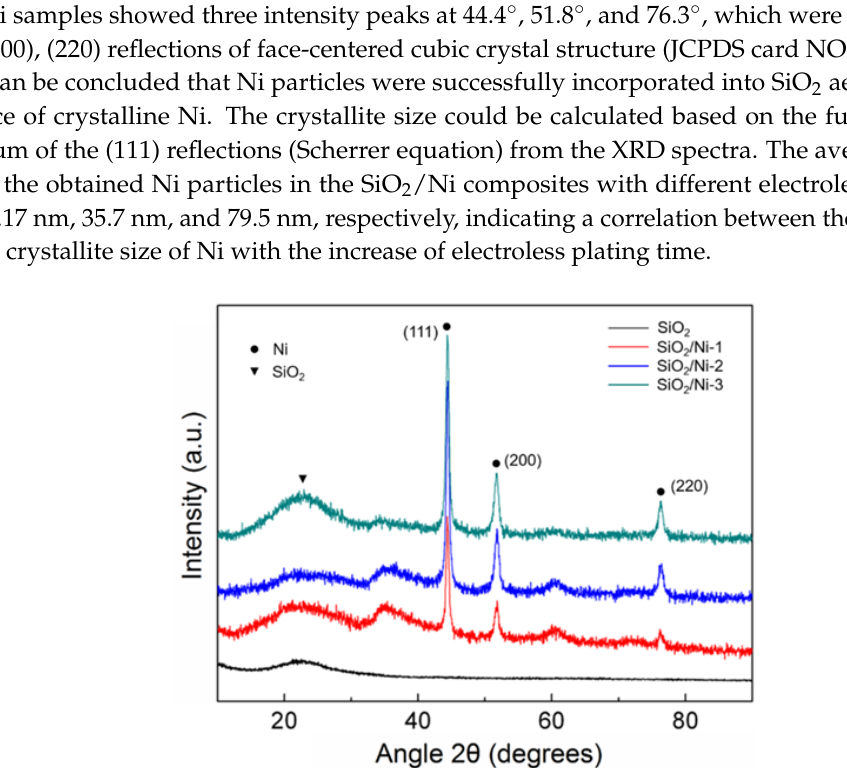
Figure 2. XRD spectrums for SiO 2 /Ni composites.